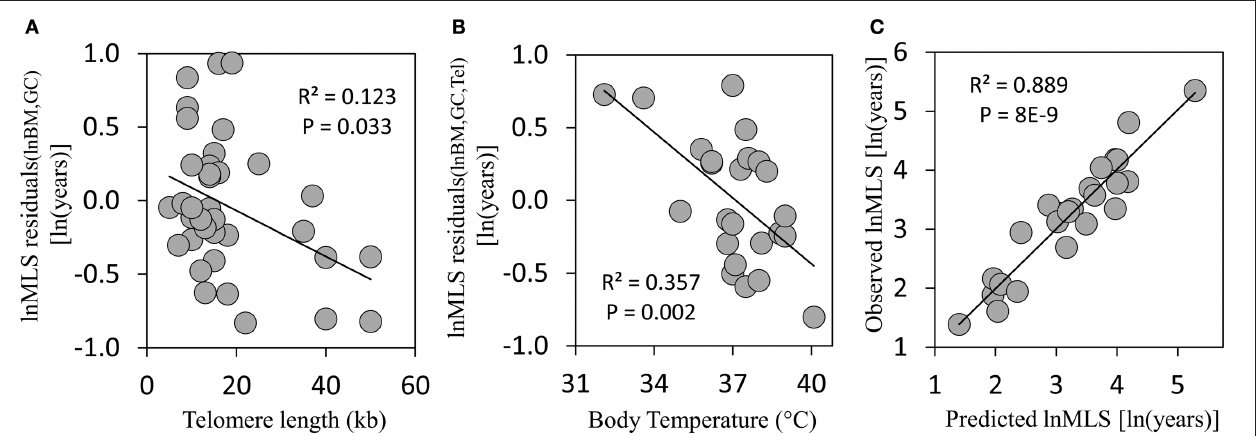
FIGURE 1 | (A) The lnMLS residuals of lnBM and mtDNA GC correlate with telomere length (Tel). (B) The lnMLS residuals of lnBM, mtDNA GC, and Tel correlate with T b . (C) Observed lnMLS plotted against predicted lnMLS. The predicted lnMLS was calculated from the multivariate linear